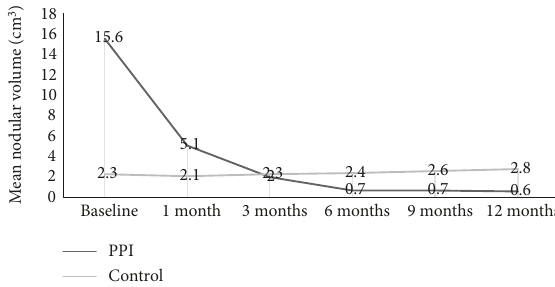
Figure 2: Volumes at baseline and the time of follow-up in the PPI group; volumes at baseline and the time of follow-up in the control group. PPI: percutaneous polidocanol